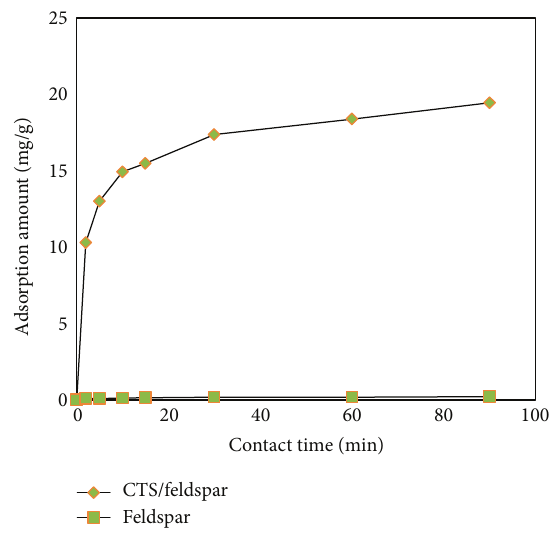
Figure 7: Effect of the adsorption time on adsorption capacity of feldspar and CTS/feldspar for AB1; experimental conditions: dye concentration, 125mg/L; pH 3.0; temperature, 15 ∘